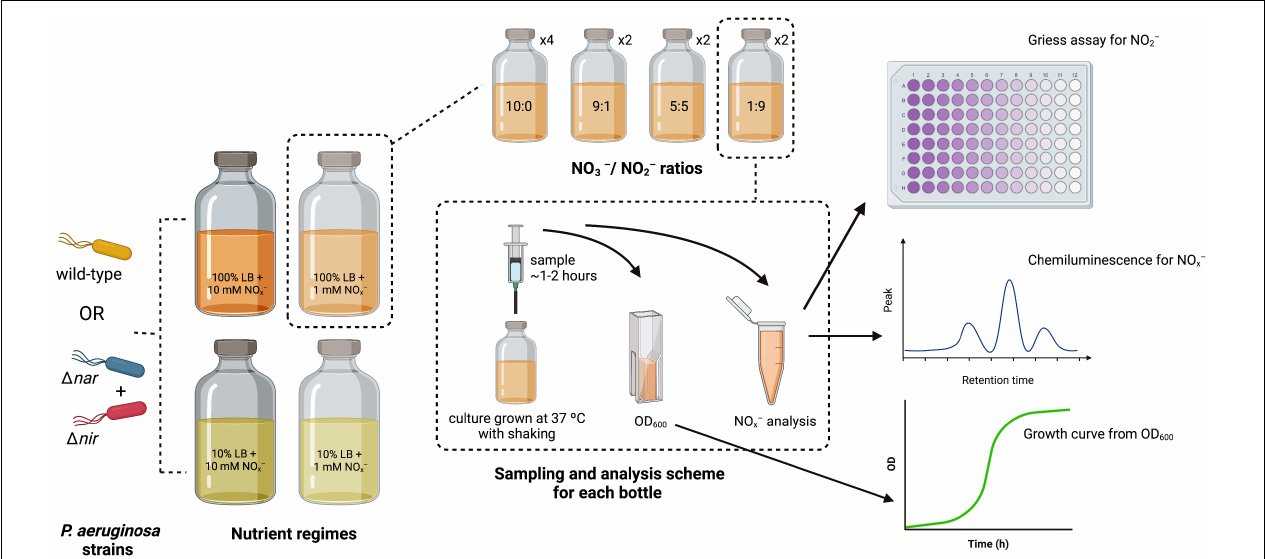
FIGURE 1 | Diagram of experimental setup, sampling scheme, and analysis methods. P. aeruginosa strains for inoculation are depicted in orange (wild-type), cyan ( (cid:49) nar ), and red ( (cid:49) nir ). Nutrient regimes are shown in large serum bottles, and stoichiometric ratios for each nutrient regime are shown in smaller serum bottles. Number of replicates for each stoichiometric ratio within each nutrient regime is indicated next to smaller serum bottles. The sampling scheme for each replicate is depicted within the dashed rectangle, along with the analyses performed on each